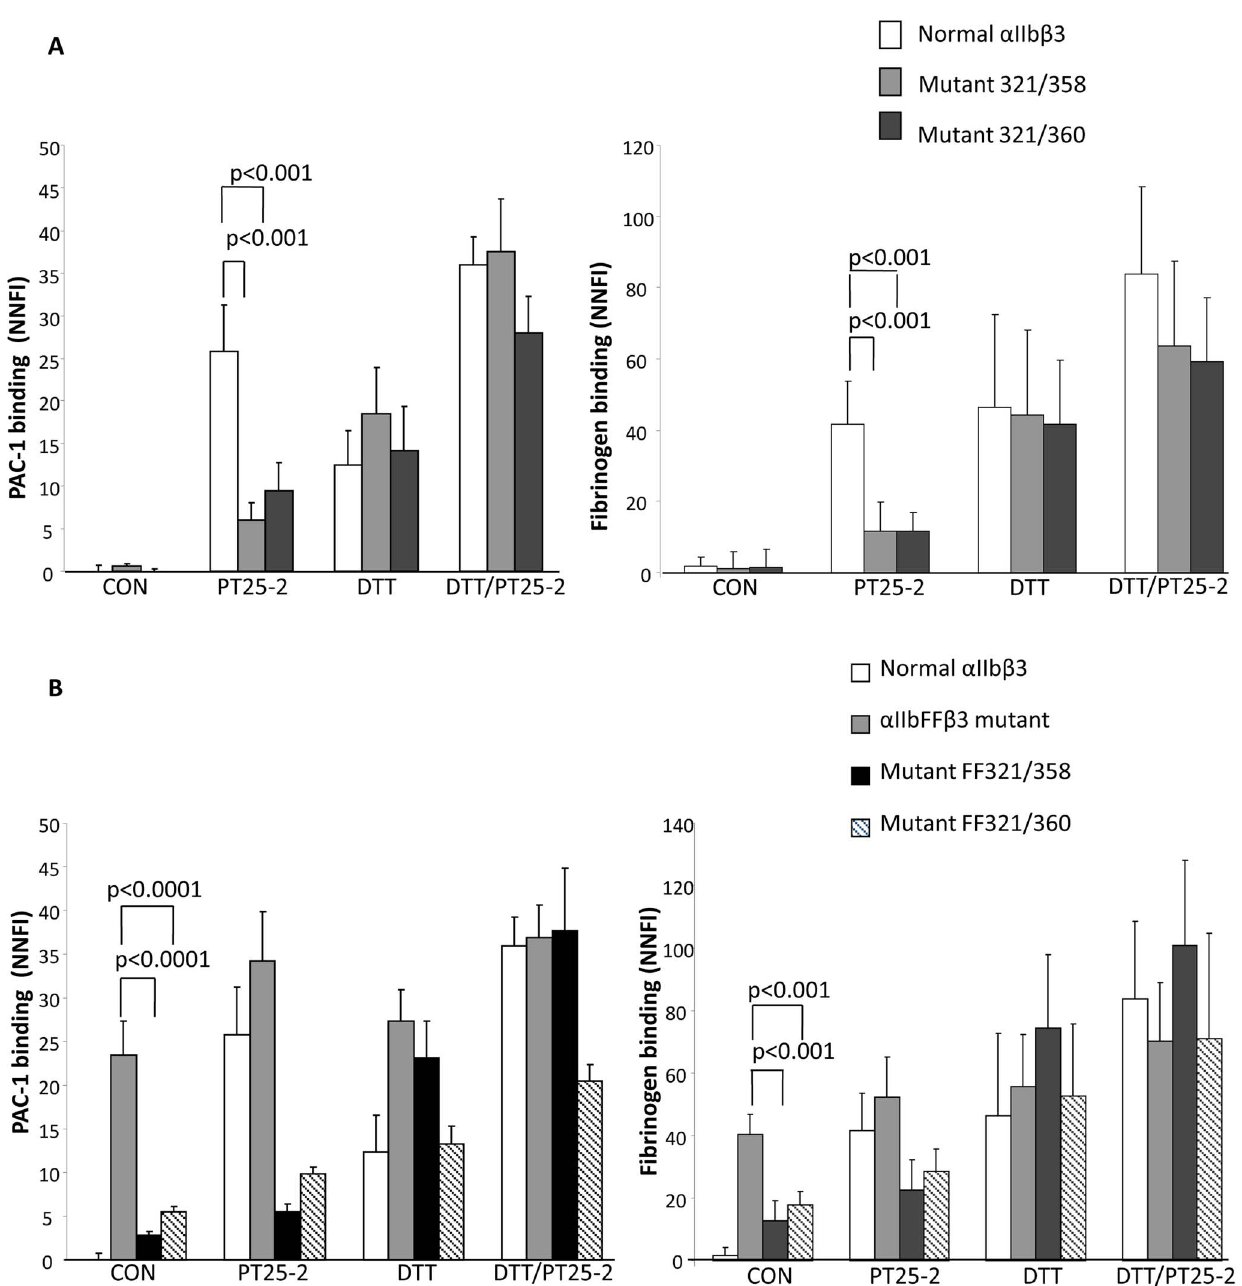
Figure 3. Cells expressing XS-O mutants have reduced ability to bind PAC-1 and fibrinogen. A . Left , PAC-1 binding of cells expressing XS-O mutants 321/358 and 321/360 the absence of treatment (control; CON) or in the presence of mAb PT25-2, DTT, or DTT + PT25-2. FITC-PAC-1 was added at 5 m g/ml and binding was assessed via flow cytometry. Binding is expressed as net normalized fluorescence intensity (NNFI), in which the geometric mean fluorescence intensity after subtracting nonspecific binding is divided by the relative surface receptor expression as judged by the binding of mAb 10E5. Data expressed as mean 6 SD; n=5. Right , Fibrinogen binding using Alexa488-fibringen (200 m g/ml) as indicated above in ‘‘ A ’’ for PAC-1 (mean 6 SD; n=6). B. The a IIb F992A/F993A activating mutations fail to rescue PAC-1 and fibrinogen binding in the XS-O mutants.